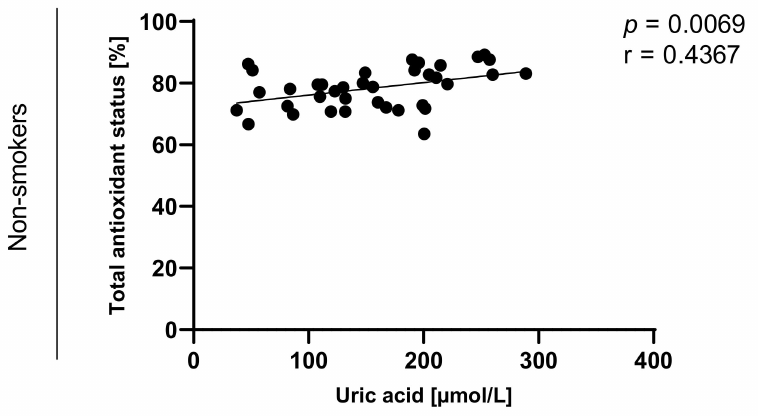
Figure 10. Correlation between uric acid and TAOS (total antioxidant status) among